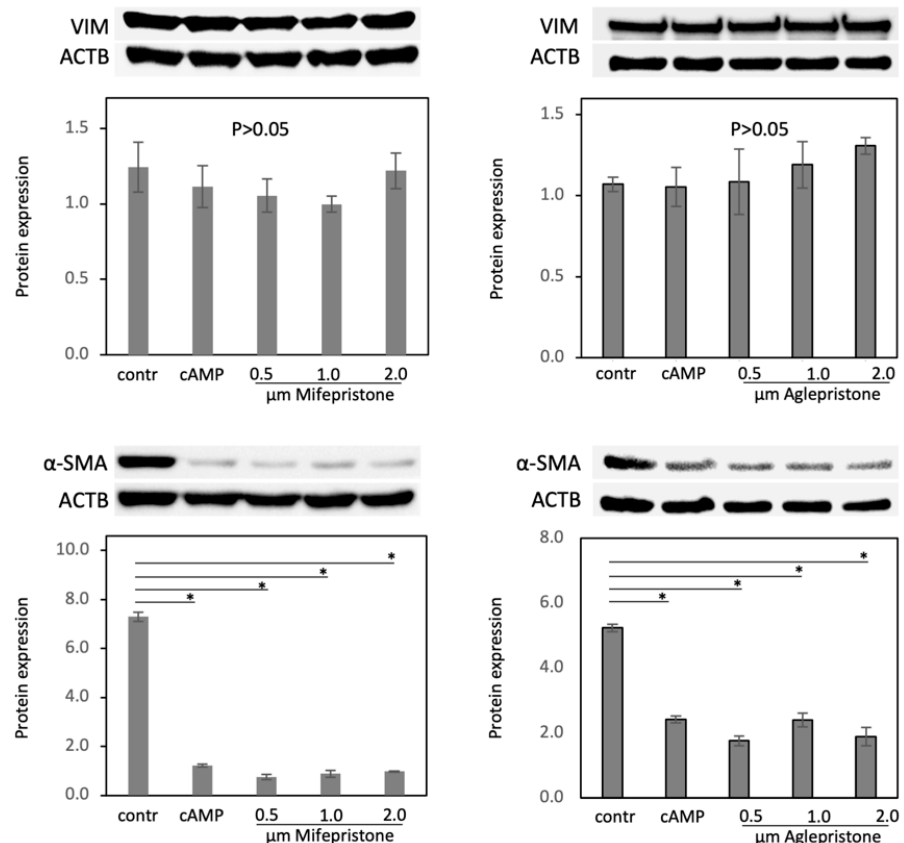
Figure 5. Expression of mesenchymal markers vimentin (VIM) and α -smooth muscle actin ( α -SMA) in decidualized and antigestagen-treated DUS cells. Optical densities of VIM (54 kDa) and α -SMA (42 kDa) were normalized against ACTB (45 kDa). One-way ANOVA was applied, revealing: p > 0.05 for VIM in response to both mifepristone and aglepristone, and p < 0.0001 for α -SMA in the presence of mifepristone or aglepristone. The ANOVA tests were followed by Tukey-Kramer multiple-comparisons test. Numerical data are presented as mean ± standard deviation (SD). Bars with different asterisks differ at: (*) p < 0.001.